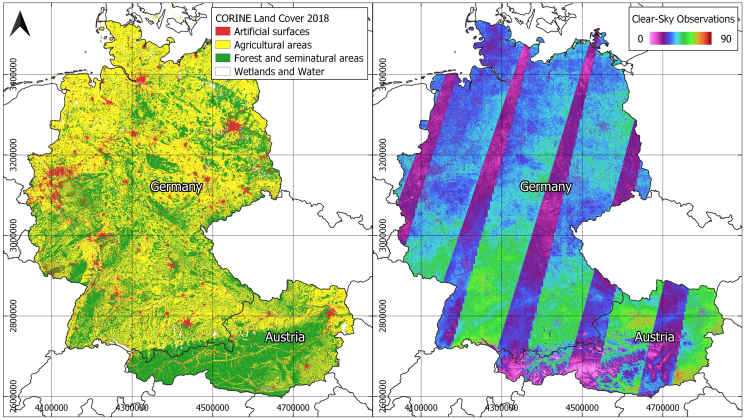
Left: CORINE Land Cover Product 2018. Right: Clear-sky observations per pixel in the study area. Stripes of higher availability are due to Sentinel-2A/B orbit overlaps. Total range of 0–110 observations was clipped at 90 for illusStrative purposes.